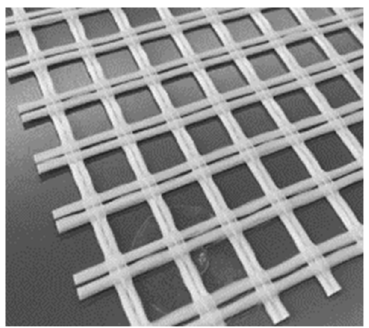
Figure 4. Planar, 2D glass textile.